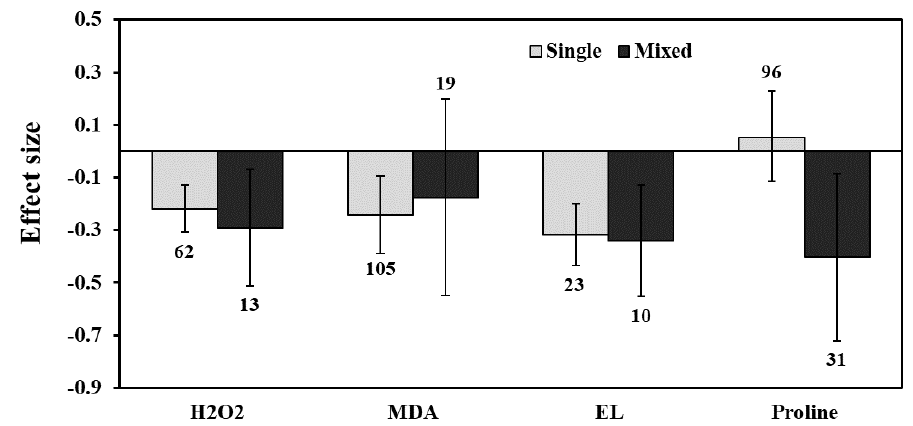
Figure 5. Categorical analysis of AMF inoculation type on H 2 O 2 , MDA, EL, and Proline levels. Error bars are means ± 95% confidence intervals (CIs). Where the CIs do not overlap the horizontal lines, the effect size for a response variable is significant at p < 0.05. The numbers of observations are shown above the bar. Note: H 2 O 2 − Hydrogen peroxide, MDA − Malondialdehyde, EL − Electrolyte leakage.